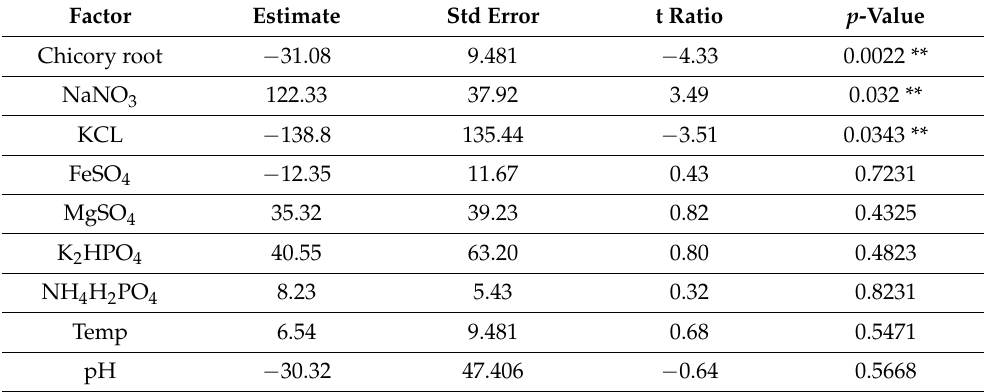
Table 5. Estimated effects, corresponding t ratios, and p -values for the Plackett–Burman design experiment.